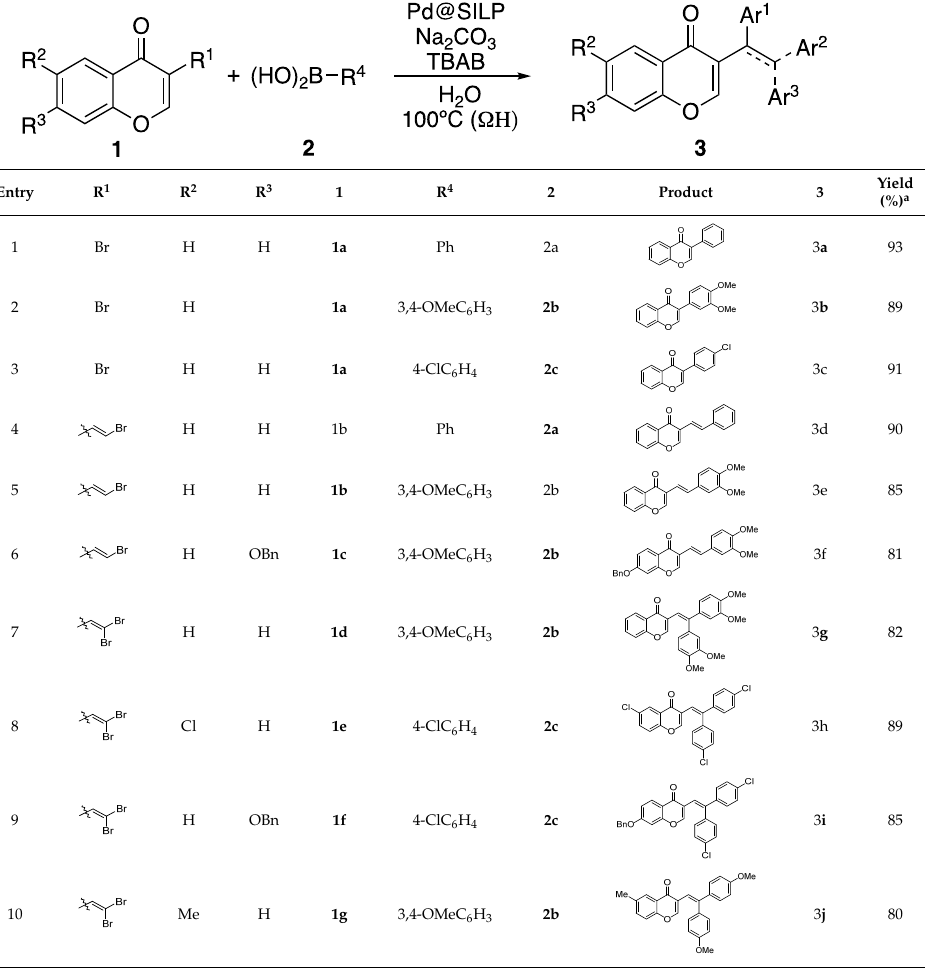
Table 2. Suzuki–Miyaura reactions of bromoflavones 1 with arylboronic acids 2 .